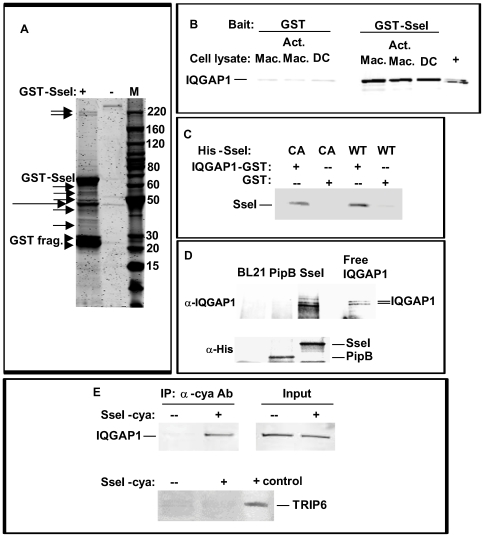
SseI binds directly to the cell migration regulator IQGAP1.A) Purified GST-SseI (or GSH-resin alone) was used to co-precipitate SseI binding proteins from whole cell extracts of BMDM. Bound proteins were eluted and subjected to SDS-PAGE (4–20% gradient gel) and stained with Coomassie blue. Arrows denote bands that were excised and analyzed by mass spectrometry (top doublet is IQGAP1). Long arrow: non-SseI-specific binding; arrowheads: GST-SseI breakdown fragments. B) GST-SseI (or GST alone) pre-bound to GSH-resin was added to whole cell extracts of BMDM (Mac), activated BMDM or BMDC (DC), and bound proteins were immunoblotted for IQGAP1 (+ = HeLa cell extract). C) Purified His-SseI (WT) or His-SseIC178A (CA) proteins were co-precipitated with IQGAP1-GST or GST alone using GSH-resin and bound SseI was detected by immunoblot using anti-His tag antibody. D) In addition, free IQGAP1 was co-precipitated with His-SseI, His-PipB, or resin prepared from E. coli BL21 extract alone, and IQGAP1 was detected by immunoblot using anti-IQGAP1 antibody. E) BMDM were infected with S. typhimurium-expressing SseI-cya (or SseI alone), and 6h later proteins were immunoprecipitated with anti-CyaA antibody. Bound proteins were immunoblotted for IQGAP1 or TRIP6 (+control = whole cell extract of NIH3T3 cells).